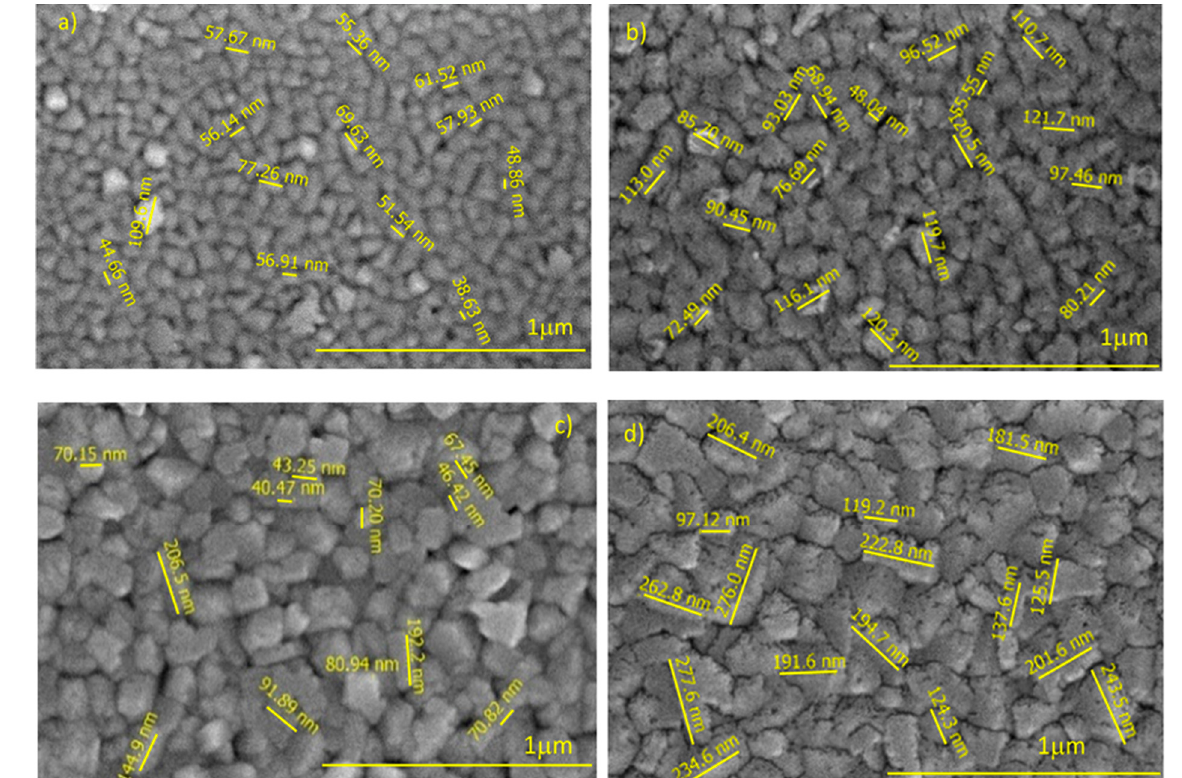
Figure 5. SEM image of the 2%Fe doped WO 3 layer grown at 4 h deposition time and various temperatures. ( a ) T = 600 °C; ( b ) T = 650 °C; ( c ) T = 680 °C and ( d ) T = 700 °C.